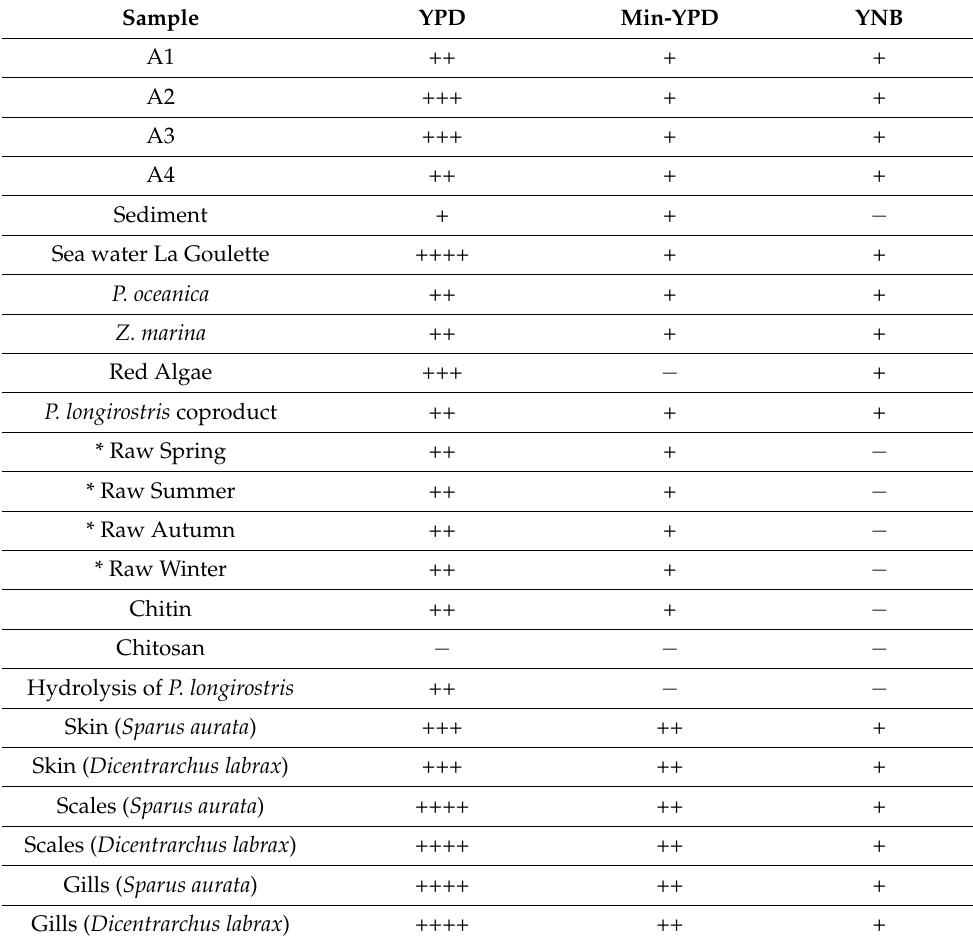
Table 2. Growth of isolated yeasts from different Tunisian marine sources in different broth media according to their biomass productivity